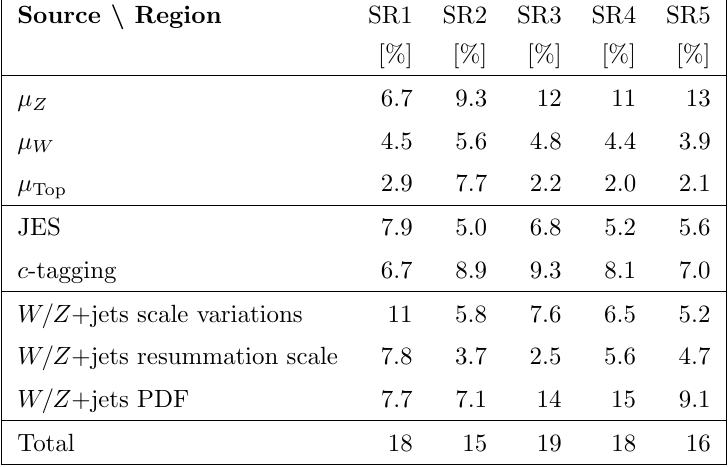
Table 6 . Summary of the dominant experimental and theoretical uncertainties for each signal region. Uncertainties are quoted as percentages of the total SM background predictions. The individual uncertainties can be correlated, and do not necessarily add in quadrature to the total background